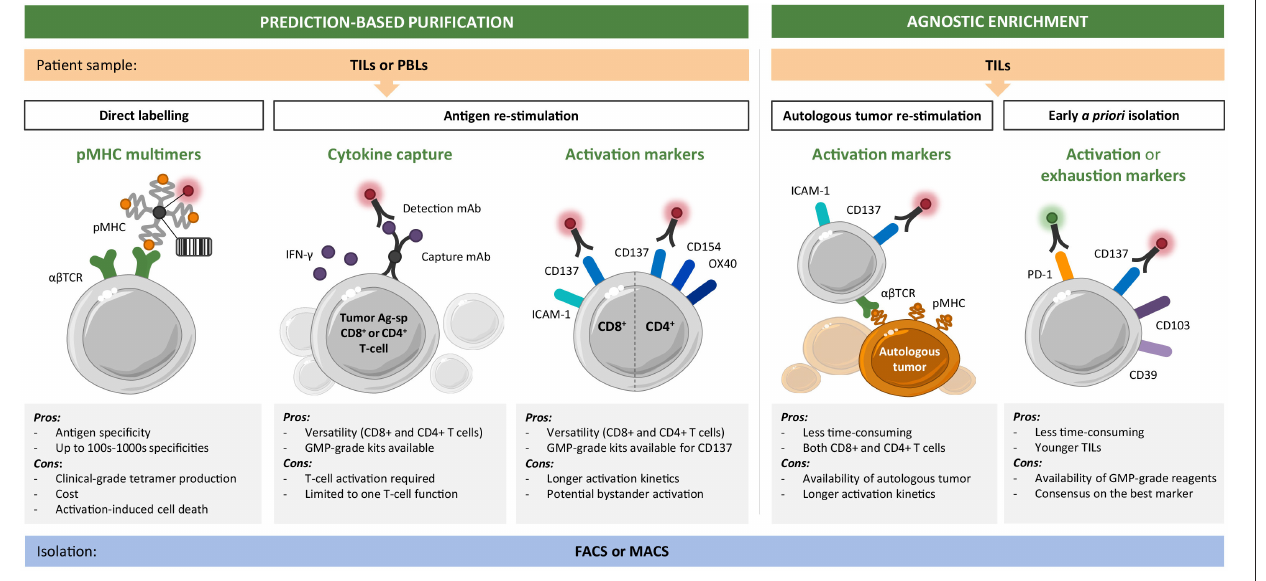
FIGURE 2 | Toolset for personalized enrichment of T-cell infusion products. Current technologies can be grouped into neoantigen-specific purification strategies, which rely on predictions and predefined epitope selection, and agnostic enrichment strategies based on coculture with autologous tumor or a priori identification of tumor-reactive T-cells. The main advantages and disadvantages of each approach are listed. CD8 + (and CD4 + ) T-cells of interest can be isolated starting from tumor infiltrating lymphocyte (TIL) or peripheral blood lymphocyte (PBL) cultures by fluorescence-activated (FACS) or magnetic bead-activated (MACS) cell